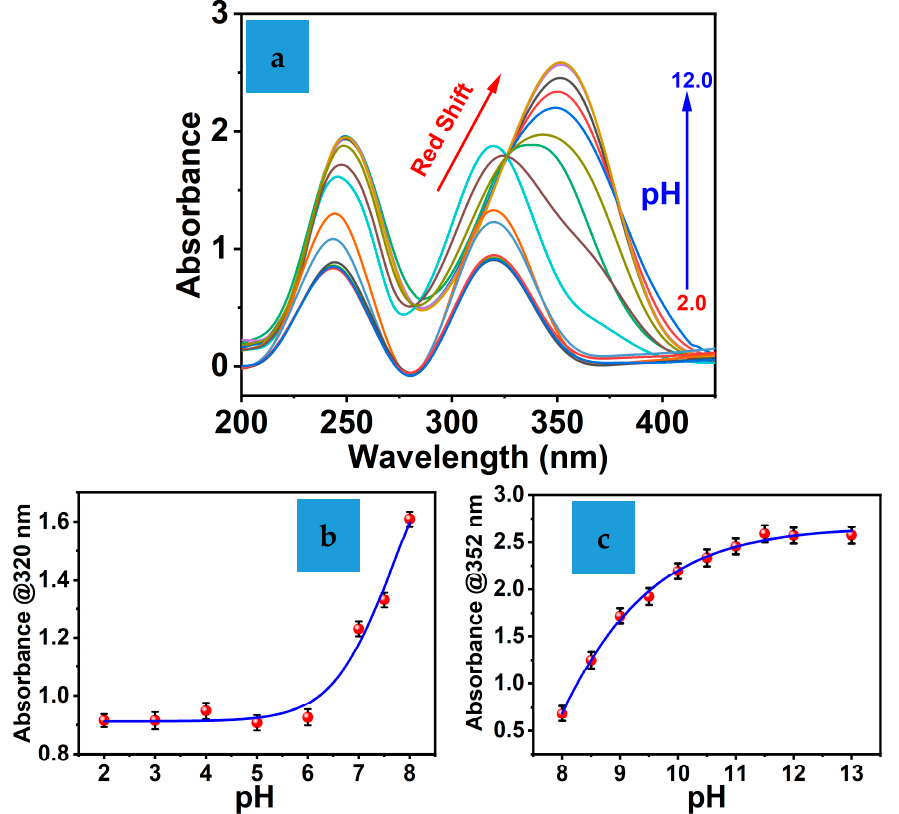
Figure 2. ( a ) Absorbance spectra of IXZD at various pH values; ( b , c ) the absorbance of the IXZD versus pH.